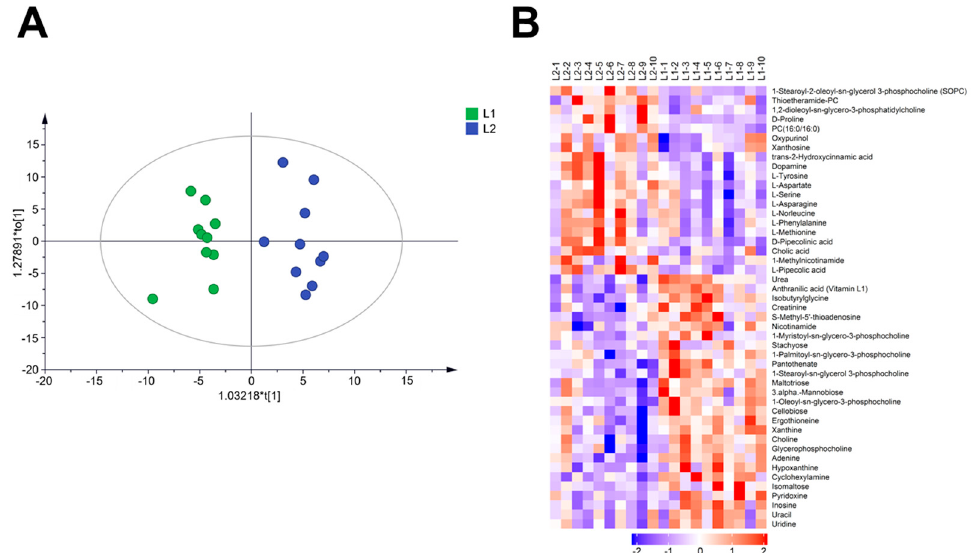
Figure 2. E ff ects of Au@Ag NRs on metabolic profiles of mouse liver. ( A ) Metabolic cluster analysis using an orthogonal partial least squares discrimination analysis (OPLS-DA) scores plot. The component t[1] is the predicted principal component, maximumly reflecting the inter-group di ff erences, while intra-group variation is reflected in t0. L1-N is the control group and L2-N is the mice received multiple administration of Au@Ag NRs (N = 1–10); ( B ) heat maps of di ff erential metabolites. All of the data were obtained under positive